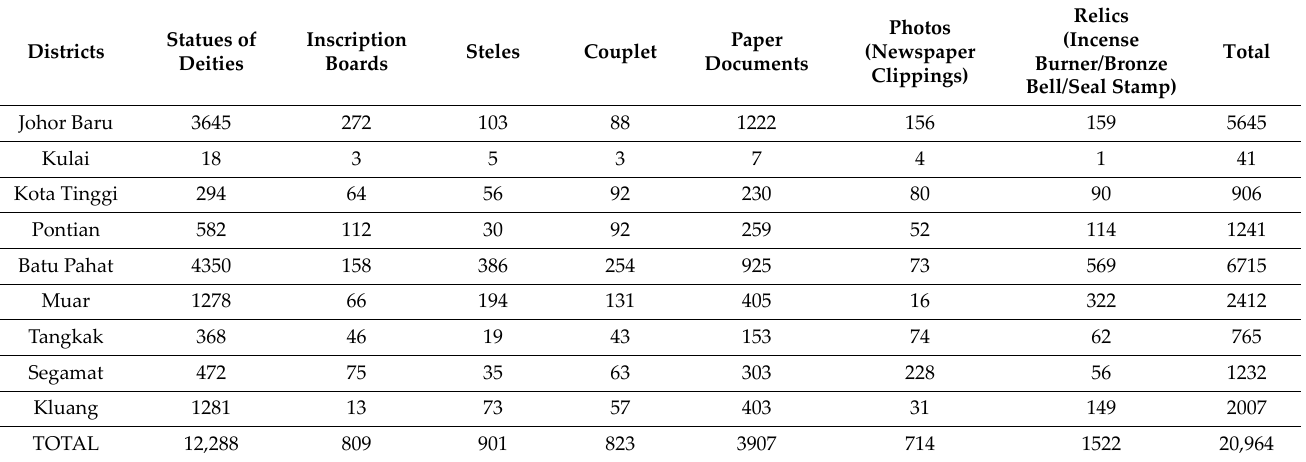
Table 1. Total Artefacts and Paper